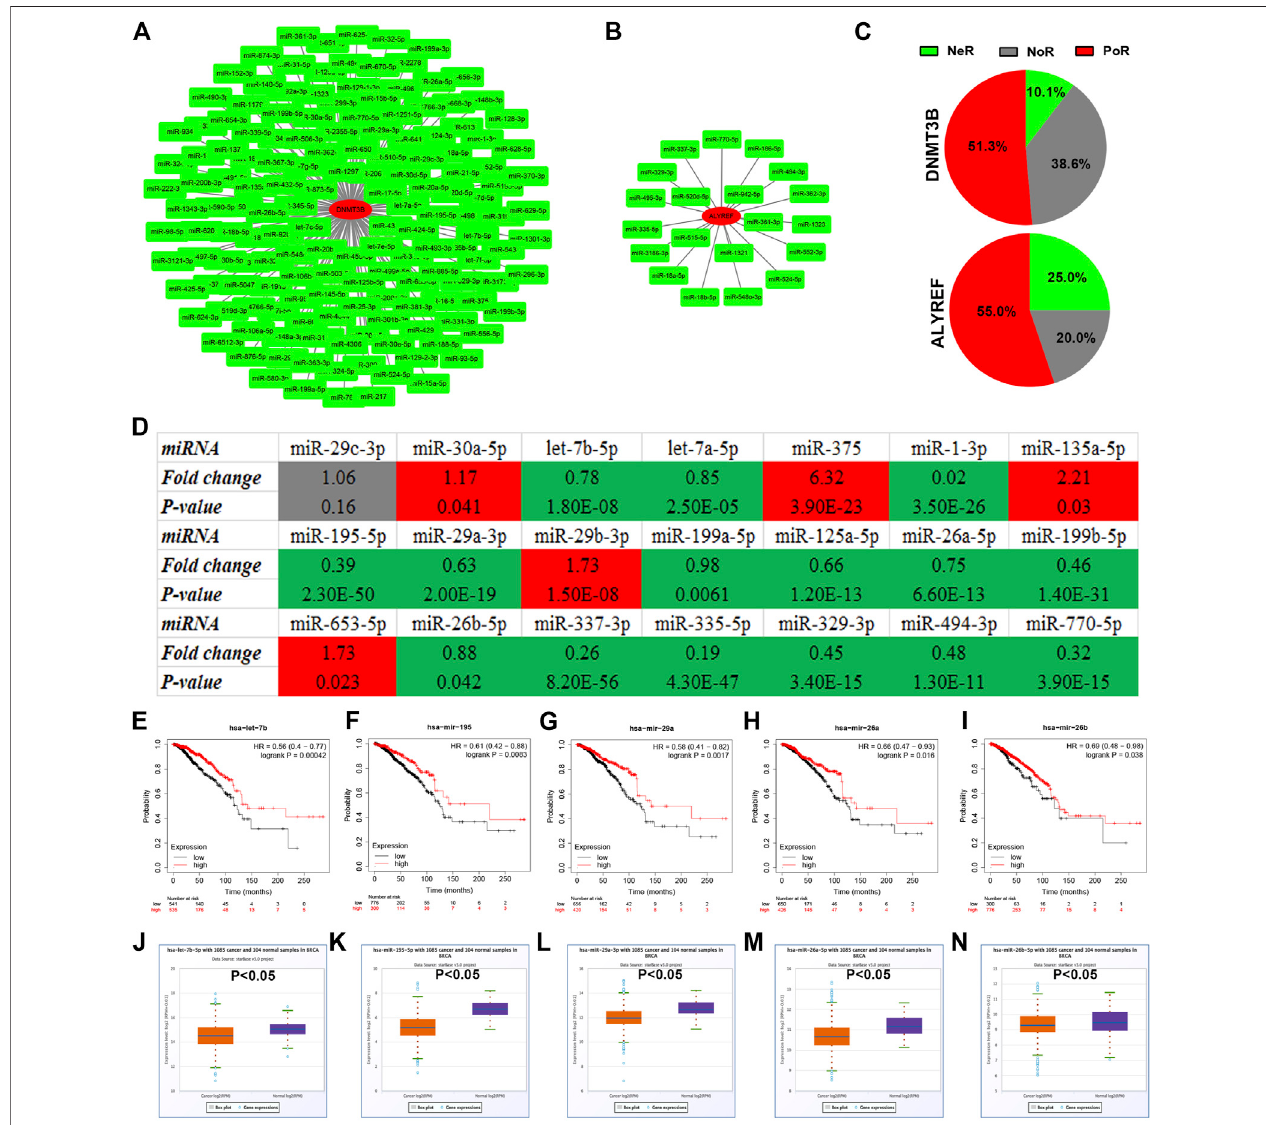
FIGURE 2 | Identi fi cation of potential miRNAs of m 5 C regulators in breast cancer. (A) miRNA – DNMT3B network. (B) miRNA-ALYREF network. (C) Distribution of expression correlation among miRNA-DNMT3B or miRNA-ALYREF pairs. NeR: negative correlation; PoR: positive correlation; NoR: no signi fi cant correlation. (D) ExpressionlandscapeofcandidatemiRNAsofDNMT3BorALYREFinbreastcancer.Theprognosticvaluesoflet-7b-5p (E) ,miR-195-5p (F) ,miR-29a-3p (G) ,miR-26a- 5p (H) , and miR-26b-5p (I) in breast cancer. The expression levels of let-7b-5p (J) , miR-195-5p (K) , miR-29a-3p (L) , miR-26a-5p (M) , and miR-26b-5p (N) in breast